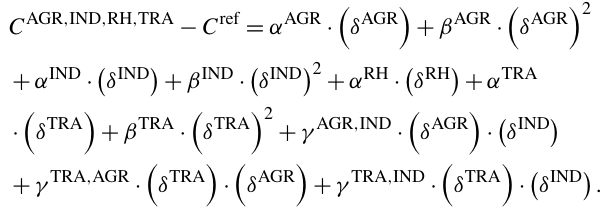
during the June 2017 max